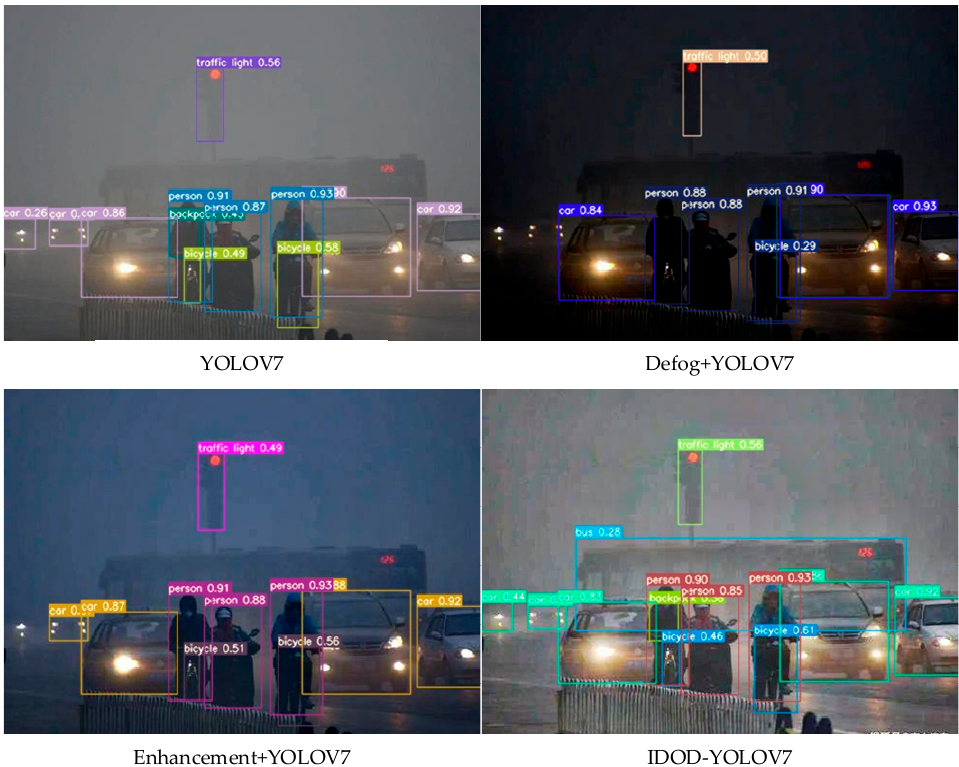
Figure 8. Ablation study object detection results of YOLOV7, Defog + YOLOV7, Enhancement + YOLOV7, and our IDOD-YOLOV7 on low-light foggy traffic images. The proposed method has better detection performance with fewer missed and wrong detections.